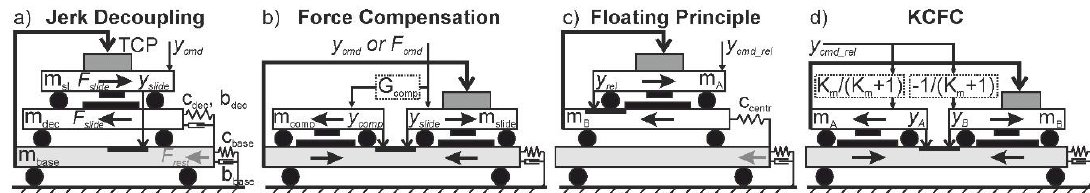
Figure 1. Principles for reduction of vibrational excitation of highly dynamic machine tools [14].